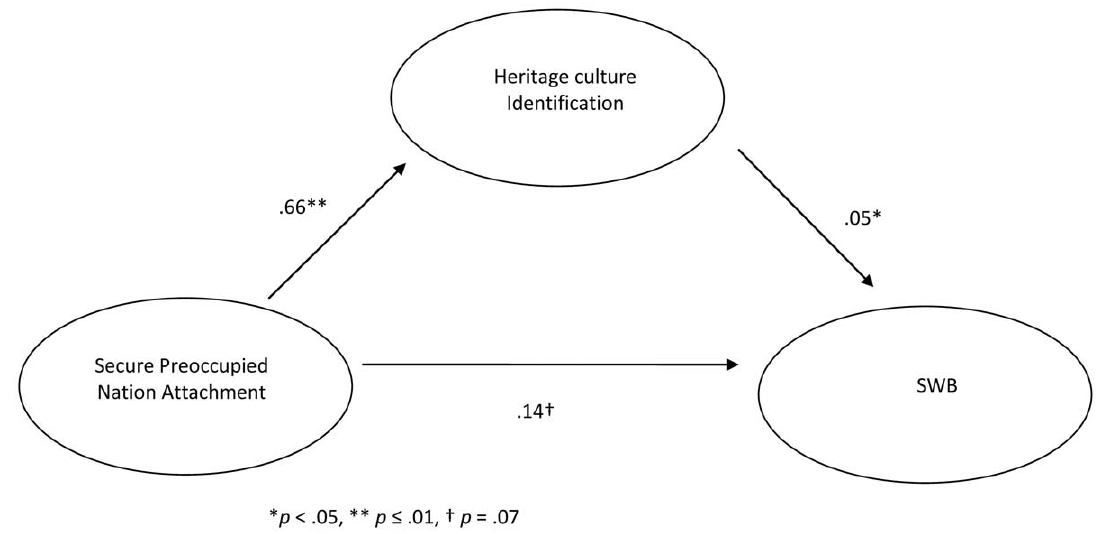
Figure 5. Mediating role of heritage culture identification on the association between secure-preoccupied nation attachment and SWB in Study 2.